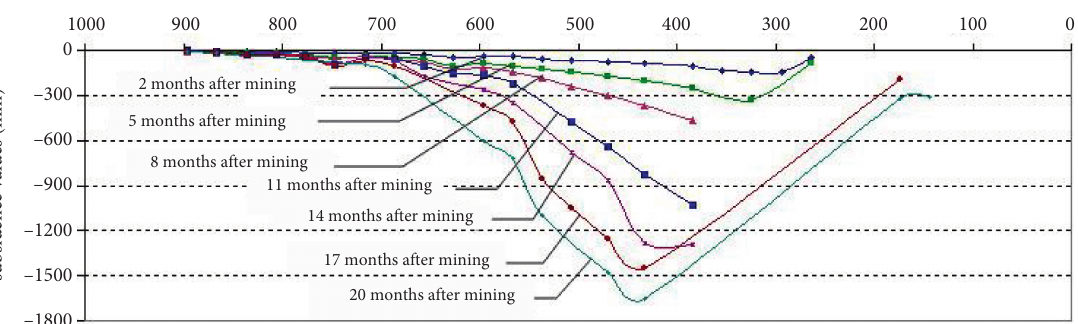
Figure 12: The typical monitored ground surface subsidence